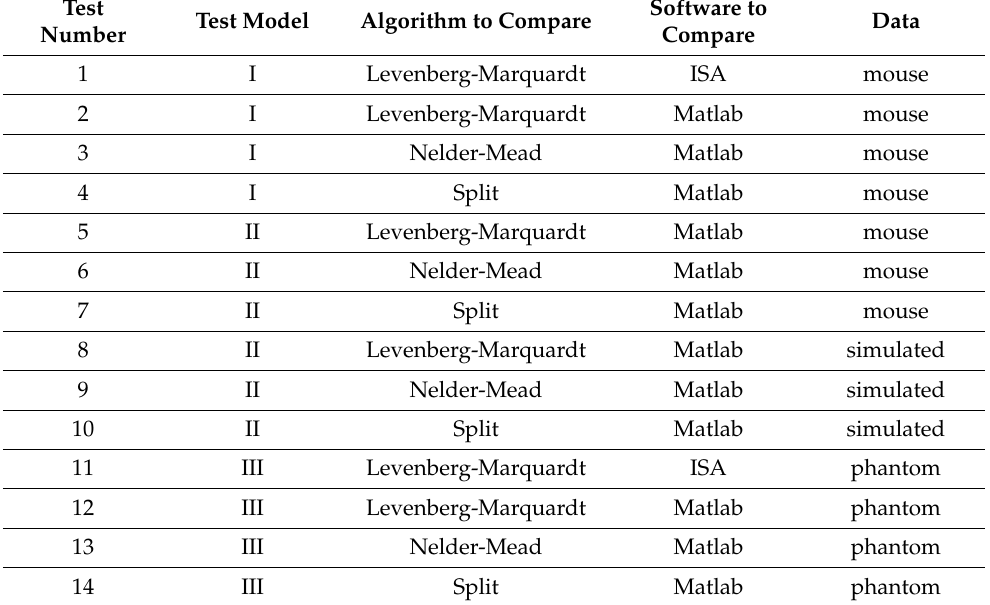
Table 2. Summary of tests performed in this article. The RD-NLS algorithm has been compared to the reported algorithm in all cases. Inversion-recovery mouse images, inversion-recovery simulated human images, and multi-slice multi-echo images were used to fit T1 and T2